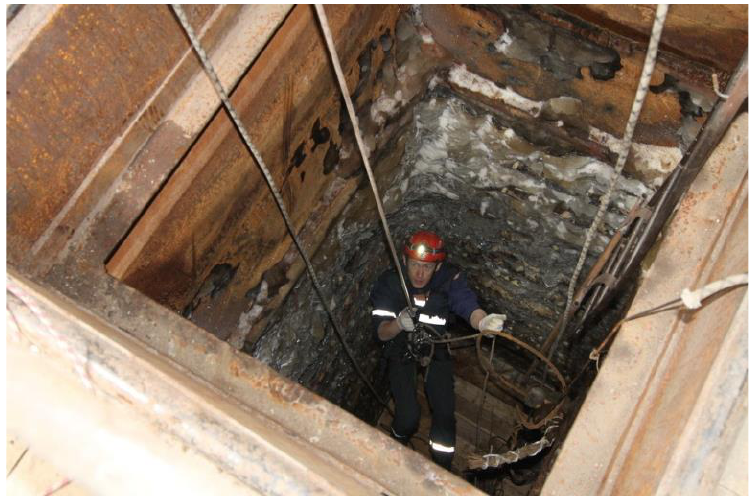
Figure 1. Shergin’s mine, Yakutsk. One of the first temperature measurements of permafrost was carried out here from 1844 to 1846, as part of Alexander Middendorf’s expedition. https://sakhaday.ru/news/kakoj-budet-dalnejshaya-sudba-shahty-shergina (accessed on 3 April 2022).